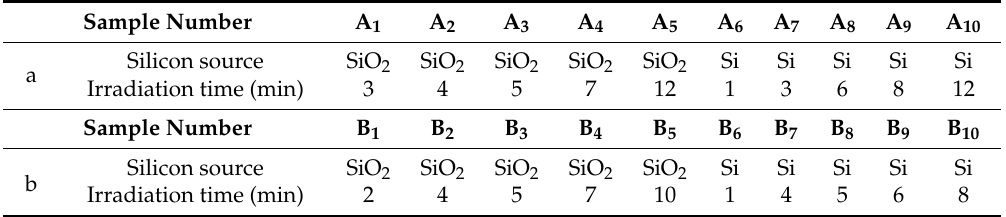
Table 1. Selected RMMC samples and reaction Table 1 . Selected RMMC samples and reaction conditions.